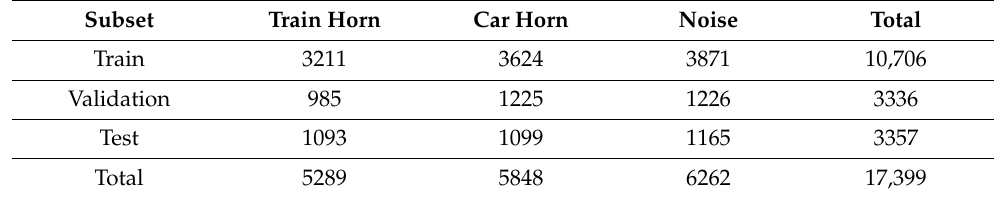
Table 2. Data separation for TH-TAD